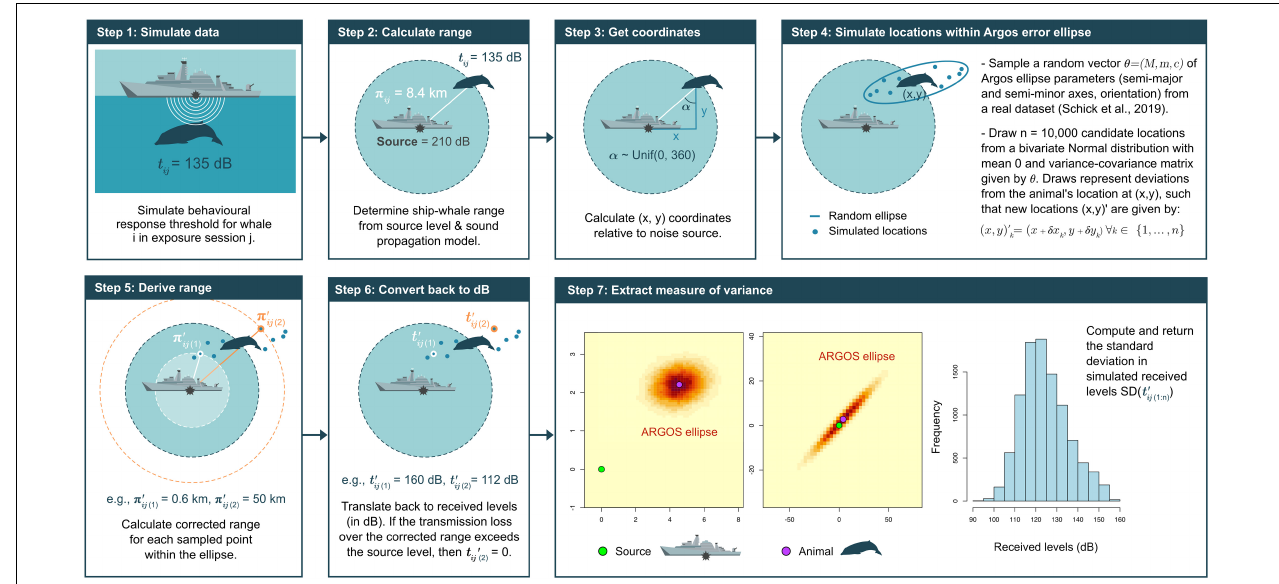
FIGURE 2 | Schematic of the approach taken to estimate sampling uncertainty on Argos-linked satellite tags (S-TAGs). Step 4 is informed by a real-world dataset on Cuvier’s beaked whales ( Ziphius cavirostris ) tagged as part of the Atlantic BRS project (https://sea-inc.net/science/atlantic-brs/) (Schick et al., 2019).